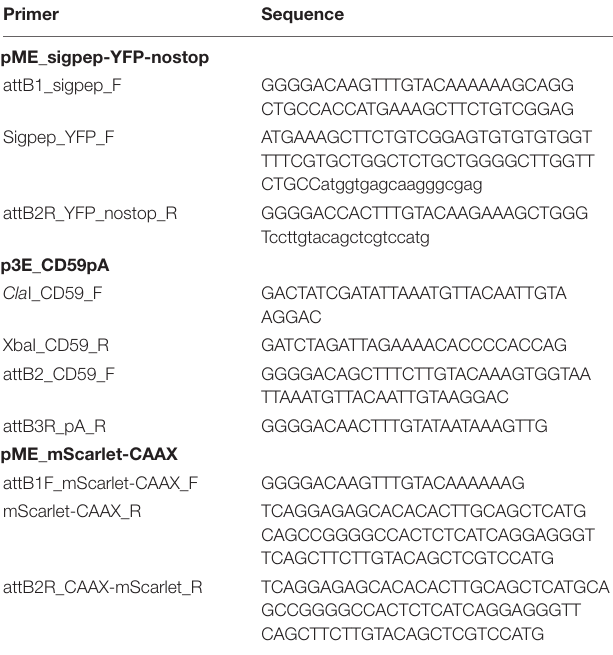
TABLE 1 | Primers used for